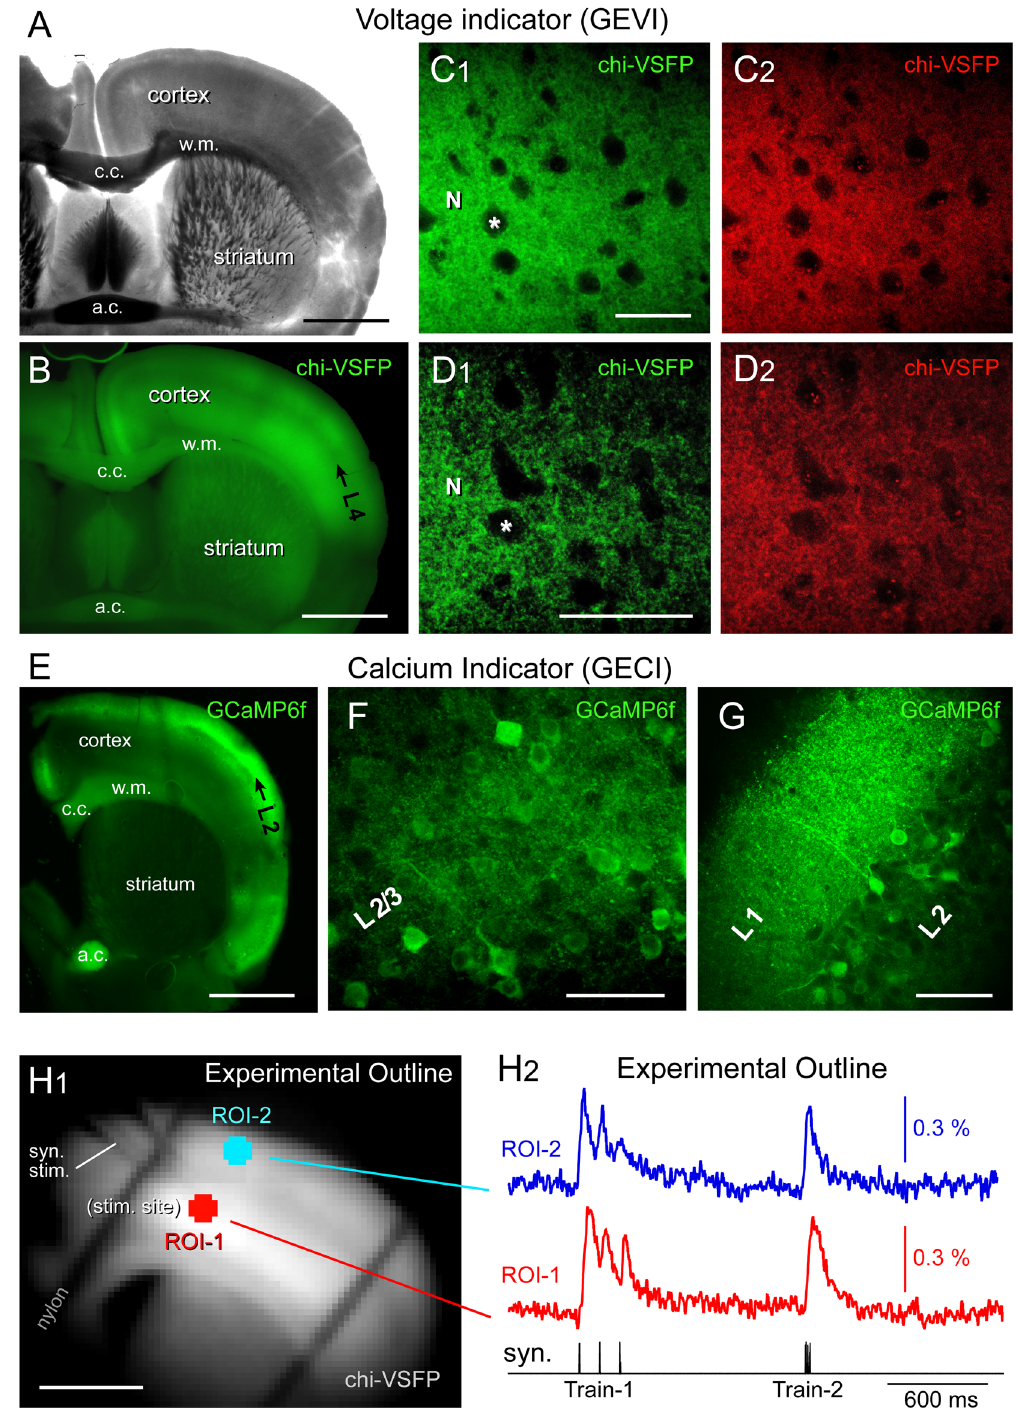
Figure 1. Transgenic animals. ( A ) Transgenic animal expressing a GEVI variant called “chi-VSFP”. P151 days, Male. A coronal section captured in transmitted light. Scale, 1 mm. ( B ) Same brain section as in ( A ), wide-field fluorescence (GFP filters). Black arrow marks cortical layer 4 (L4). “c.c.”—corpus callosum; “w.m.”—white matter; “a.c.”—anterior commissure. ( C1 ) Confocal image of the somatosensory cortex (layer 2/3) in green channel (excitation 488 nm, emission 510–545 nm). “N”—marks neuropil. “Asterisk”— marks neuronal cell body. Scale, 50 µm. ( C2 ) Same as in ( C1 ) except the emission window is now 578–625 nm. ( D1 , D2 ) Same as in ( C1 , C2 ) except the location is cortical layer 5. Scale, 50 µm. ( E ) Transgenic animal expressing a GECI variant called “GCaMP6f”. P254 days, Male. ( F ) Confocal image of the somatosensory cortex (layer 2/3) in green channel (excitation 488 nm, emission 510–545 nm). Scale, 50 µm. ( G ) GCaMP-positive neuropil in cortical layer 1. ( H1 ) One video frame obtained with data acquisition camera (80 × 80 pixel) during a voltage imaging trial (cropped). Transgenic animal expressing chi-VSFP, age P210 days, Female. Scale, 1 mm. Syn. Stim—marks a glass stimulation electrode entering the brain slice. ( H2 ) Synaptically-evoked optical signals from two regions of interest (ROIs). ROI-1 is at the stimulation site, in cortical layer 5. ROI-2 is selected form L2/3. Each trace is product of temporal averaging (4 sweeps), low-pass filtering (40 Hz cutoff, Gaussian), bleach subtraction (exponential fit) and high-pass filtering (Tau Filter = 10). Synaptic stimulation Train-1 consists of three electrical pulses at 120 ms ISI, while Train-2 employs a 12 ms